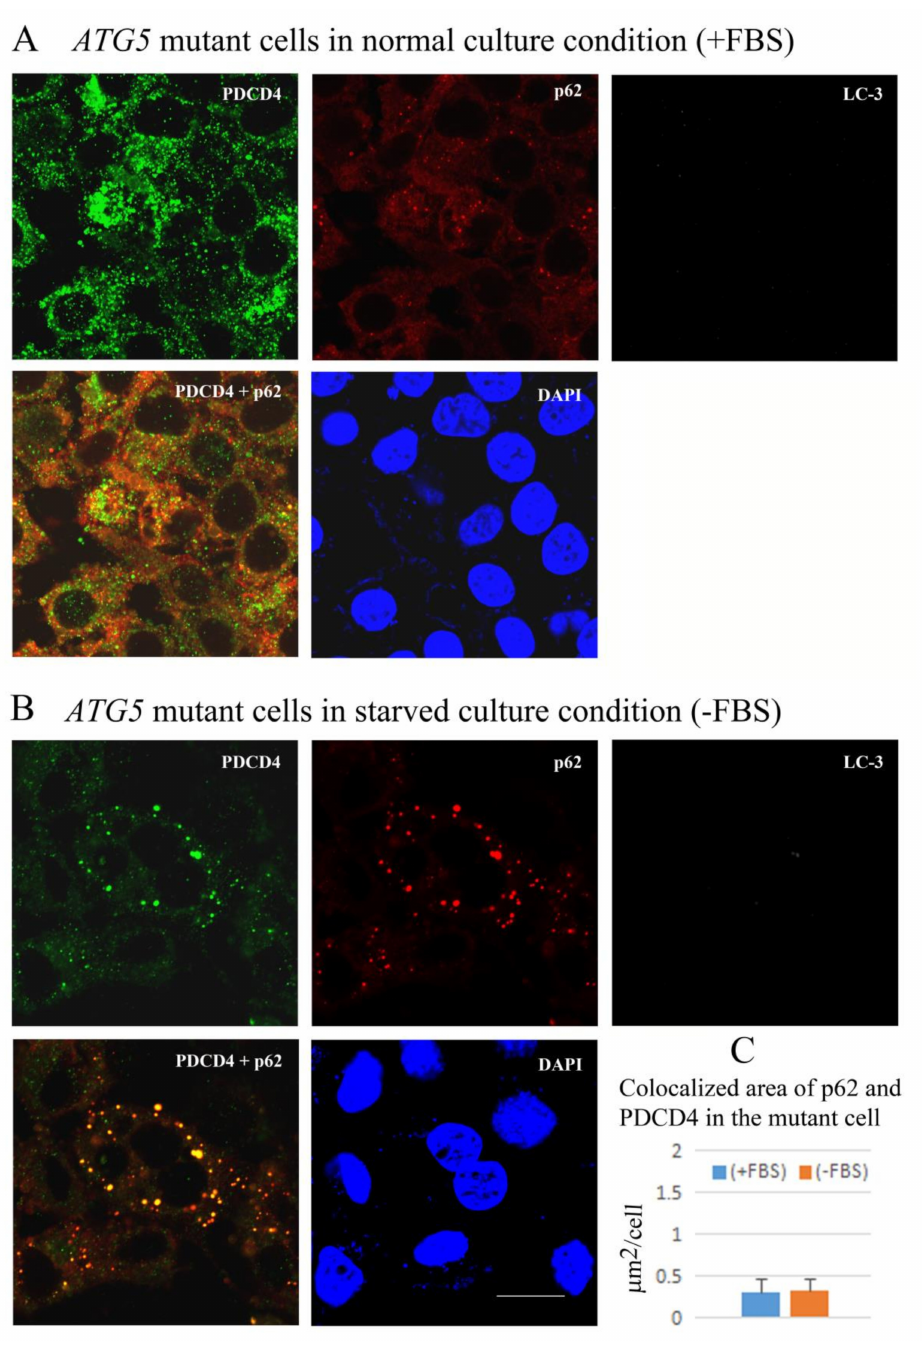
Figure 8. PDCD4 and p62 were colocalized, and the areas were slightly increased by serum starvation. The figures depicted the colocalization analyses of ATG5 mutant-16 Huh7 cells under normal ( A ) and serum-starved culture conditions ( B ). The same protocol described in Figure 7 was used for this experiment. No LC3 particles were observed in this mutant cell line, even in the absence of FBS (B). ( C ) A diagram of the colocalization areas of PDCD4 and p62. Bar = 300 µ